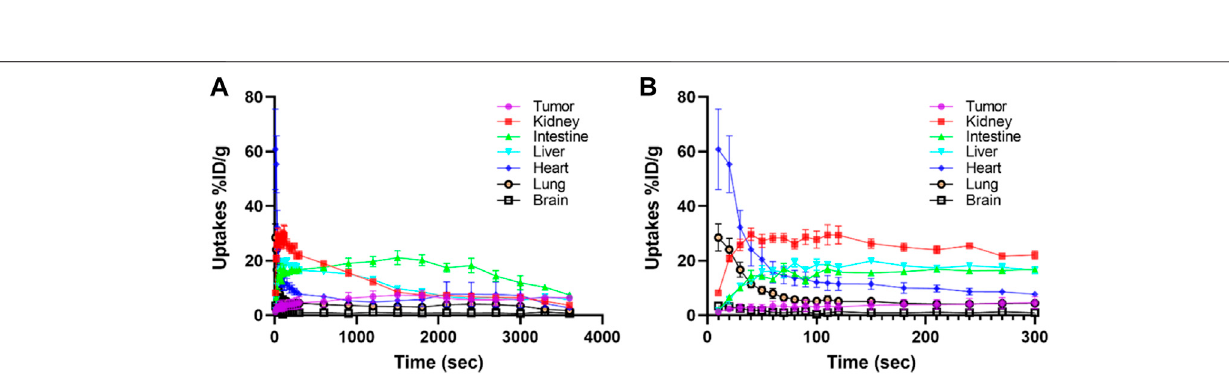
Frontiers in Chemistry |